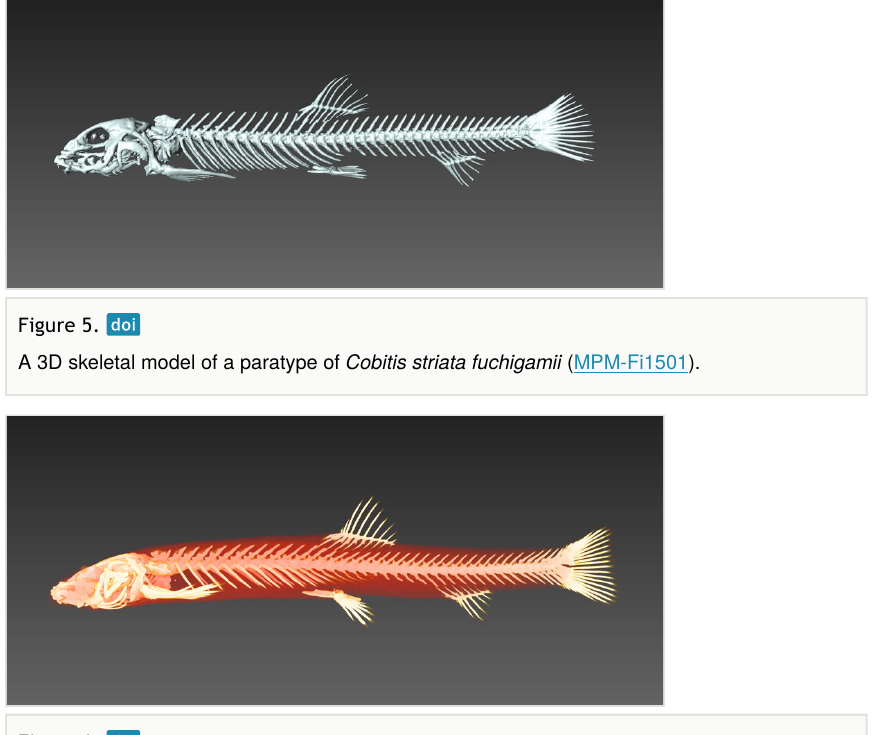
Figure 6. CT scanned data of Barbatula oreas (JNC256).